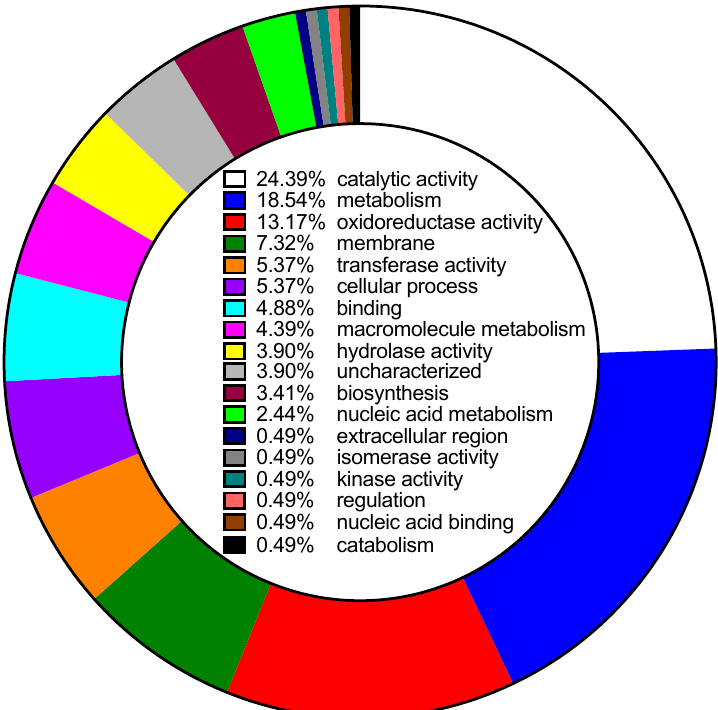
Figure 2. Gene ontology analysis of MAH Mmt7 transposon mutants identified in spermine NONOate susceptibility screen.